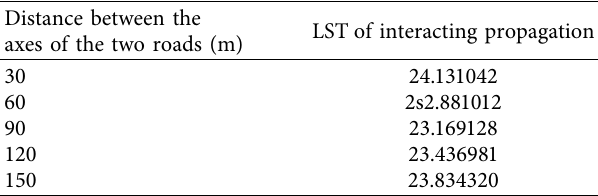
Figure 10: LST of highway interaction area. Table 6: Road LST interacting